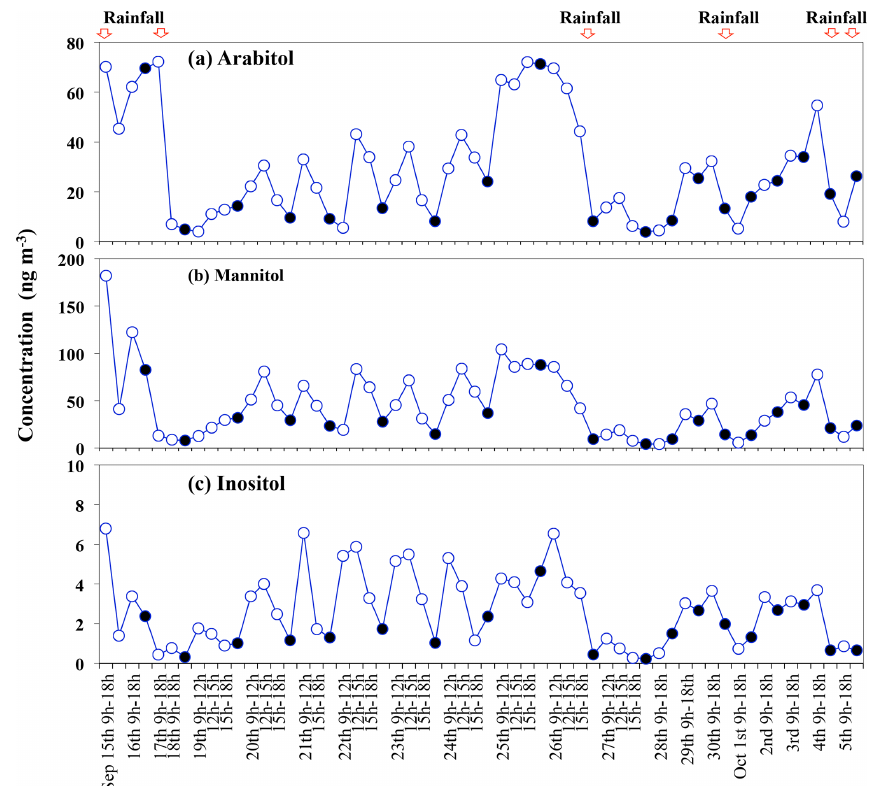
Figure 6. Temporal variations in the concentrations (ngm − 3 ) of sugar alcohols in the Mangshan aerosol samples collected for September– October 2007 (solid circle represents nighttime samples collected from 18:00 to 09:00; hollow circle represents daytime